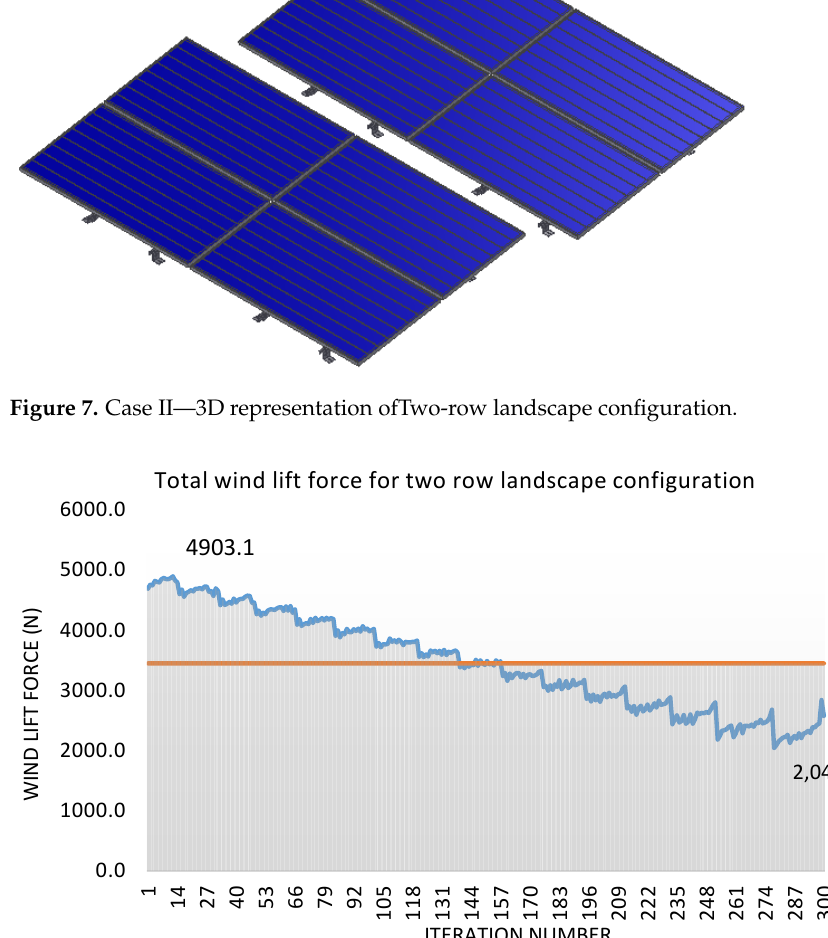
Table 4. Maximum and minimum values of the parameters for case II.